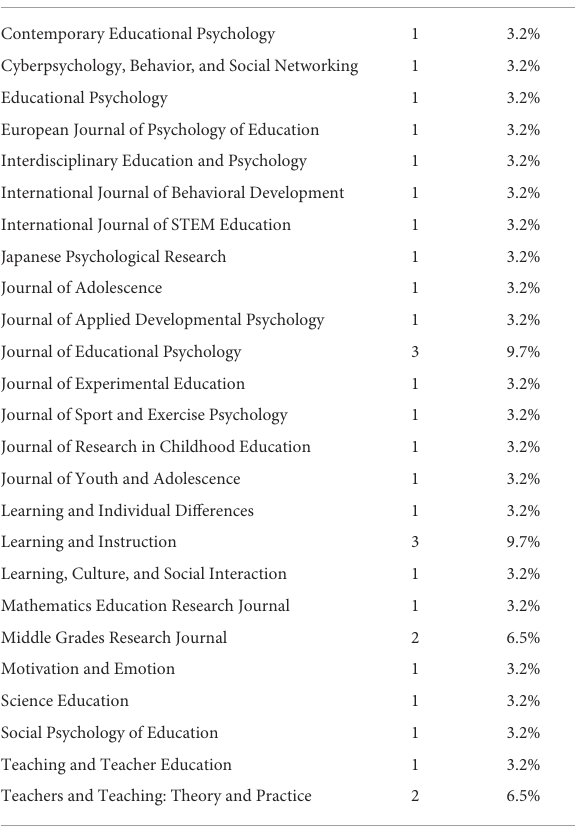
TABLE 4 Publications of identified articles. TABLE 5 The level of students studied.